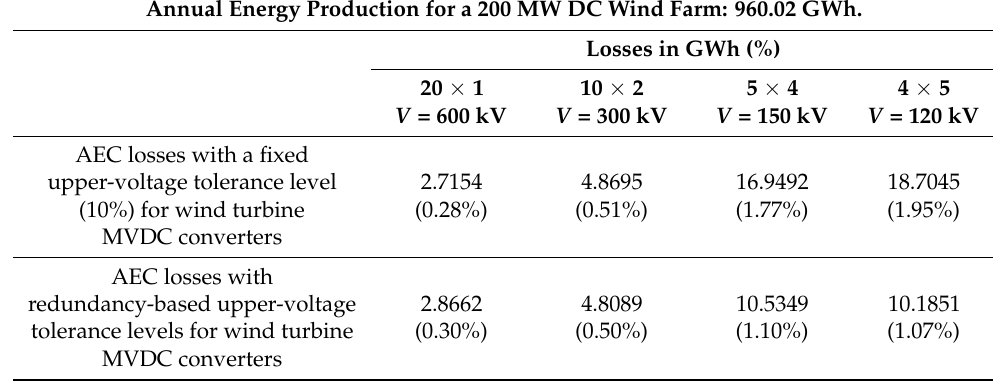
Table 3. Evaluation and comparison of AEC losses (using nominal string